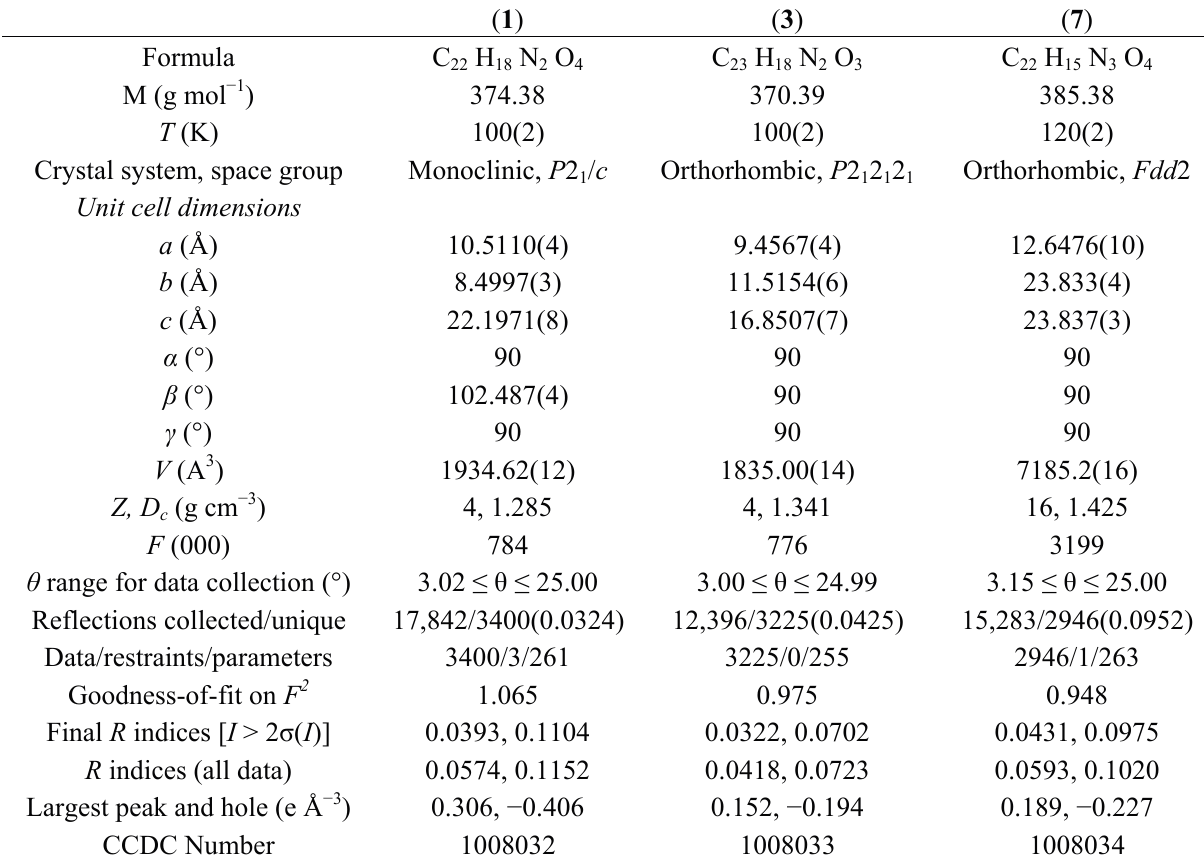
Table 1. Crystal data and structure refinements for compounds ( 1 ), ( 3 ) and ( 7